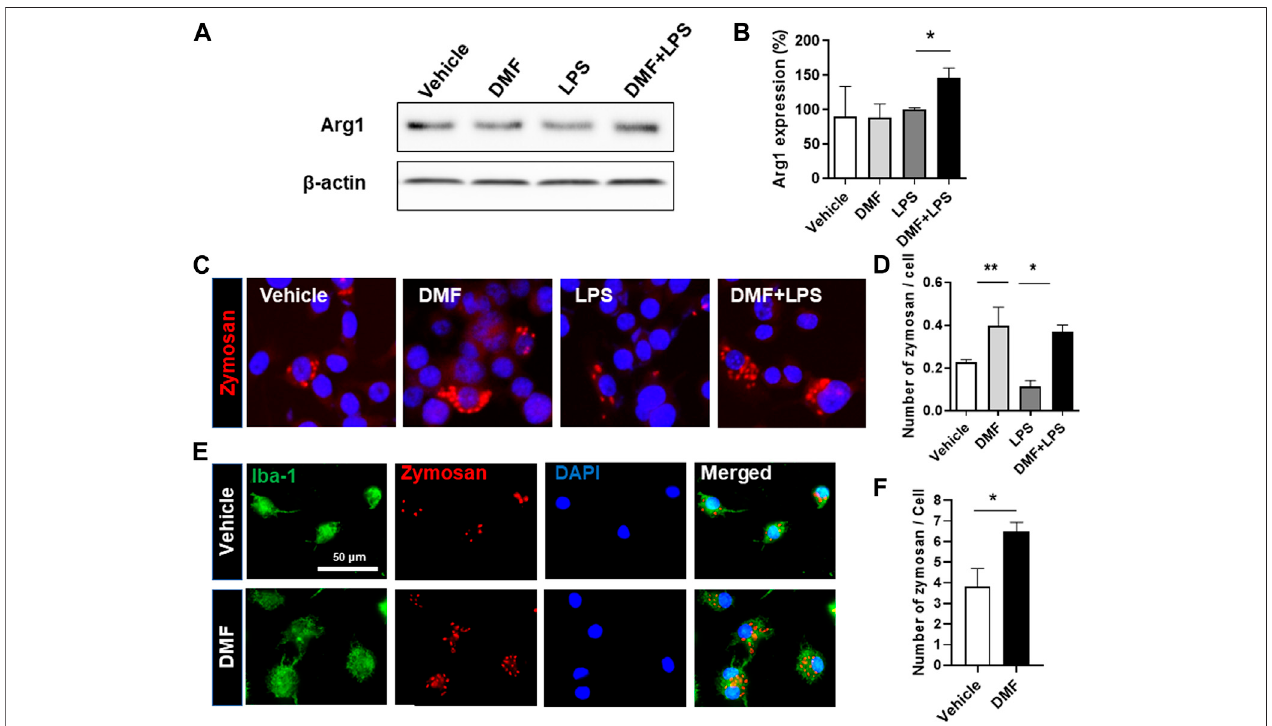
FIGURE 3 | DMF induces the neuroprotective M2 phenotype and phagocytosis in microglia (A, B) HAPI cells were seeded at 2.5 × 10 5 cells/well in a 6-well plate and incubated overnight. Cells were then treated with LPS (100 ng/ml) or DMF (4 μ M) plus LPS (100 ng/ml) for 24 h. The expression of arginase-1 protein (Arg1) was determinedbyWesternblotanalysis (B) HistogramshowsthedensitometricanalysisofWesternblots. β -actinwasusedastheloadingcontrolanddatawerenormalized tototal β -actin. n (cid:2) 3independentexperiments/group (C,D) BV-2cellswereseededat5 × 10 4 cells/wellina24-wellplateandincubatedovernight.BV-2cellswere thentreatedwithDMF(4 μ M)withorwithoutLPS(100 ng/ml)for16 h,followedbytheadditionofopsonizedzymosan-redparticlesintoBV-2cellsandthenincubatedfor another 4 h. The phagocytosed zymosan particles were counted and expressed as the number of zymosan particles per cell. A total of 463 control cells, 1117 DMF- treatedcells,990LPS-treatedcells,and636DMF+LPS-treatedcellswereanalyzed.Resultsarerepresentativeoftwoindependentexperiments.Dataarepresentedas means ± SEM. * P < 0.05, ** P < 0.01 compared with LPS-treated mice from ANOVA, Tukey ’ s multiple comparison test (E,F) Primary microglia were seeded at 5 × 10 4 cells/well in a 24-well plate and incubated overnight. The primary microglia were then treated with DMF (4 μ M) for 48 h, followed by the addition of opsonized zymosan- red particles into theprimary microglia and then incubated for another 2 h. Theprimary microglia were stained withthe anti-Iba-1 antibody.Thephagocytosedzymosan particles were counted and expressed as the number of zymosan particles per Ib1-1 positive microglial cell. A total of 157 control cells and 154 DMF-treated cells were analyzed. n (cid:2) 3 independent experiments/group. Data are presented as means ± SEM. * P < 0.05 from Student ’ s t -test between indicated two